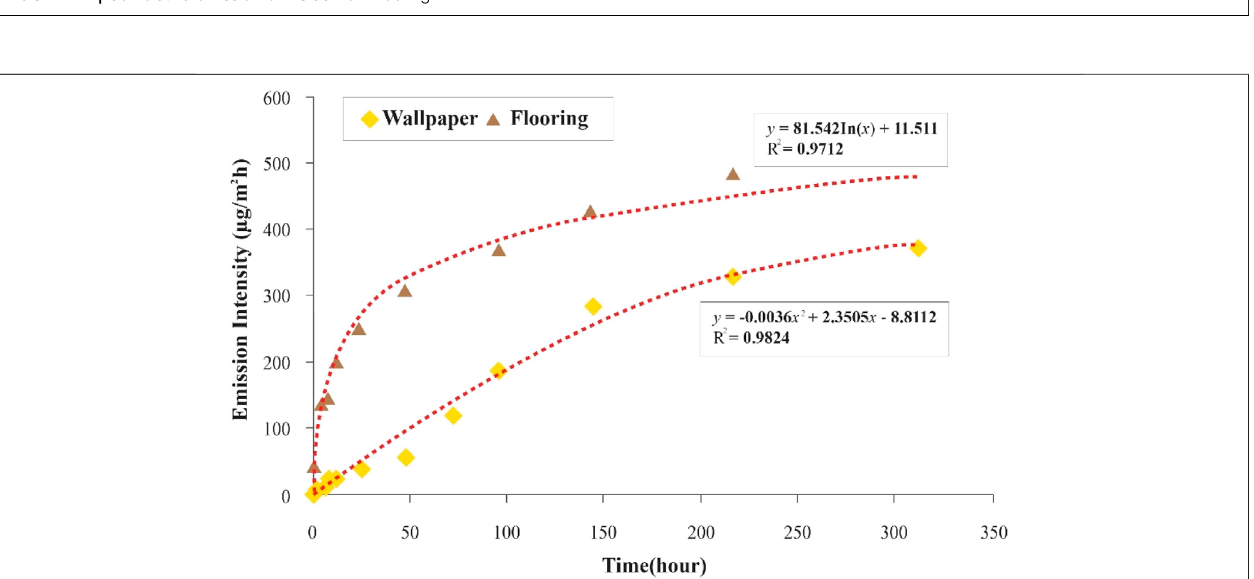
FIGURE 12 | Cumulative emission of CH 2 O from wallpaper and fl ooring.